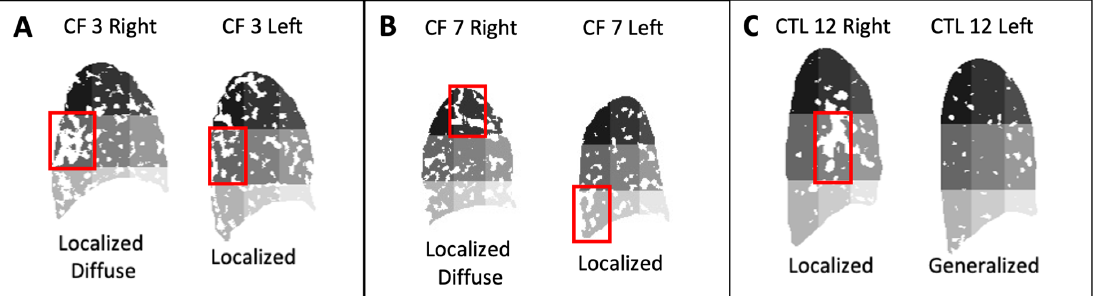
Figure 12. Subjects with differing spatial presentations in the right and left lung where red boxes mark focality region, if applicable. ( A ) CF subject 3 has a localized diffuse spatial presentation in the right lung and a localized spatial presentation in the left lung. ( B ) CF subject 7 has a localized diffuse spatial presentation in the right lung and a localized spatial presentation in the left lung. ( C ) CTL subject 12 has a localized spatial presentation in the right lung and a generalized spatial presentation in the left lung.